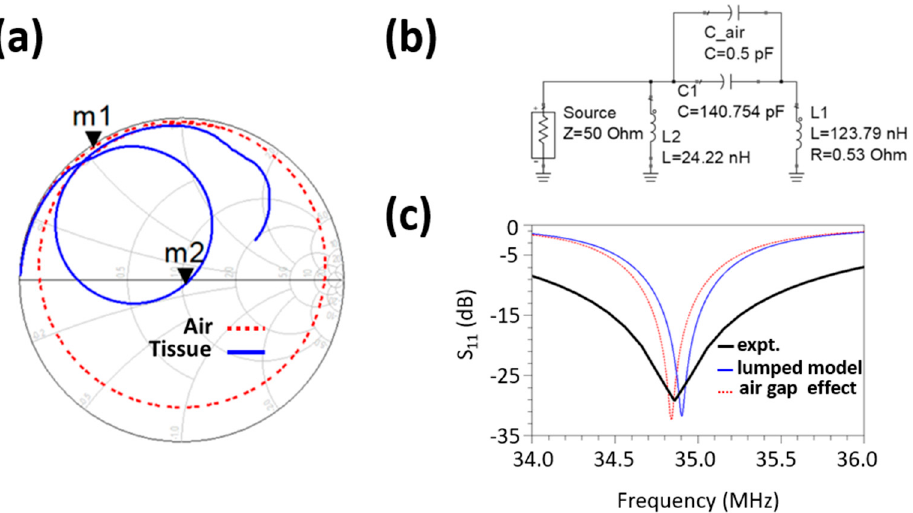
Figure 2. ( a ) Smith chart showing the complex S 11 plot of the resonator with respect to the air and over skin at radial location from 1 MHz to 100 MHz carrier frequency, ( b ) lumped RLC circuit model of the spiral resonator coupled with tissue and air gap capacitance, and ( c ) comparison of the S 11 magnitude plot resulting from the lumped model to showcase the probable effect of air gap at the resonator tissue interface.